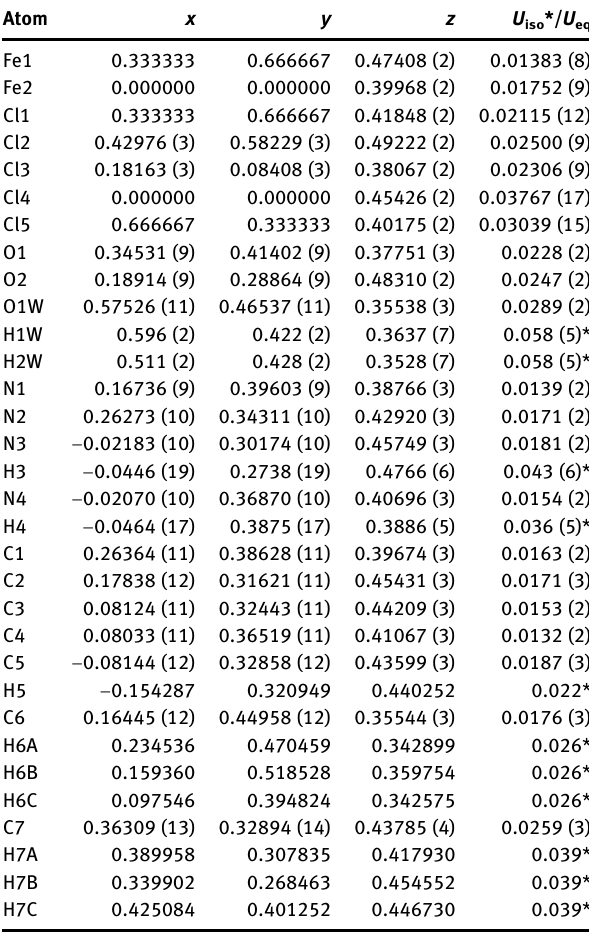
Table  : Fractional atomic coordinates and isotropic or equivalent isotropic displacement parameters (Å 